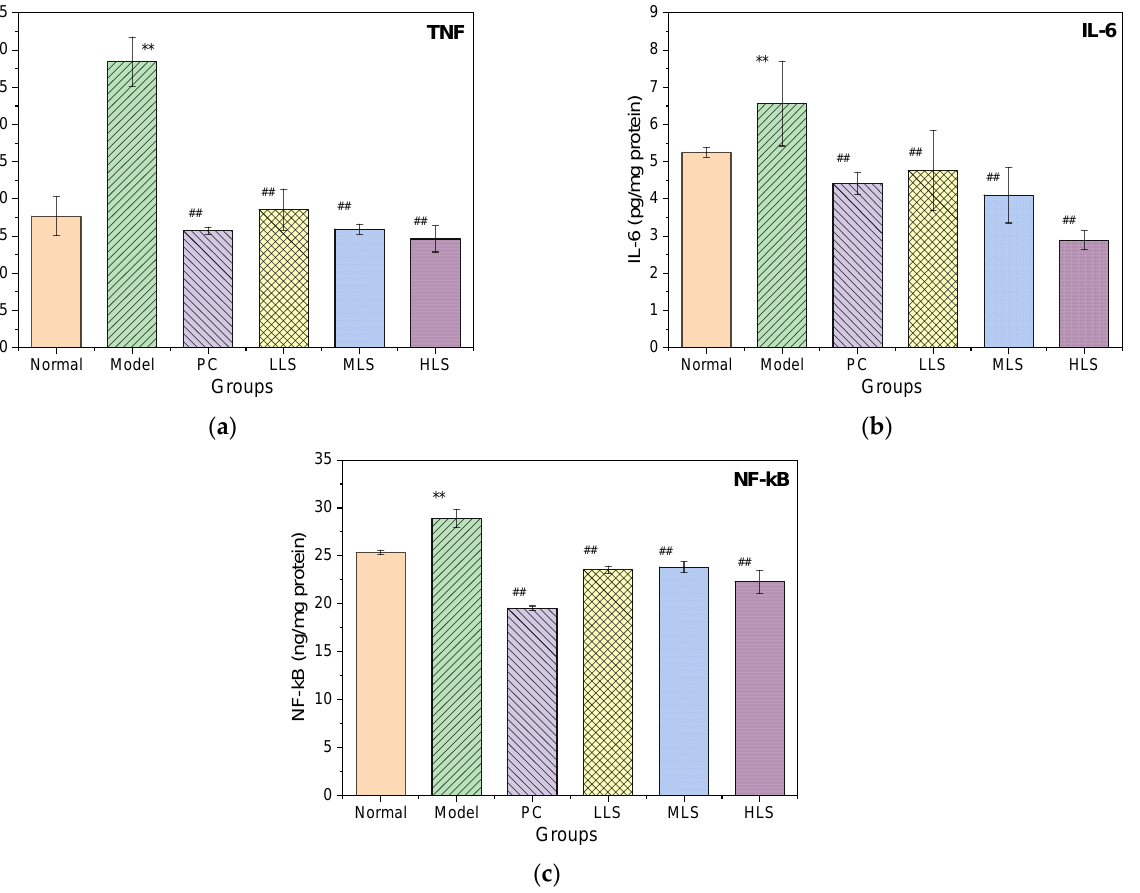
Figure 4. Effect of oral sericin on TNF- α, IL -6, and NF- κB levels in livers of T2D rats. ( a – c ) are TNF- α, IL -6, and NF- κB levels, respectively. Normal: normal group; Model: diabetic model group; PC: 0.5% melbin administration; LLS, MLS, and HLS: 1%, 2.5%, and 5% L. n = 3, ** p < 0.01 versus normal group. ## p < 0.01 versus model group.